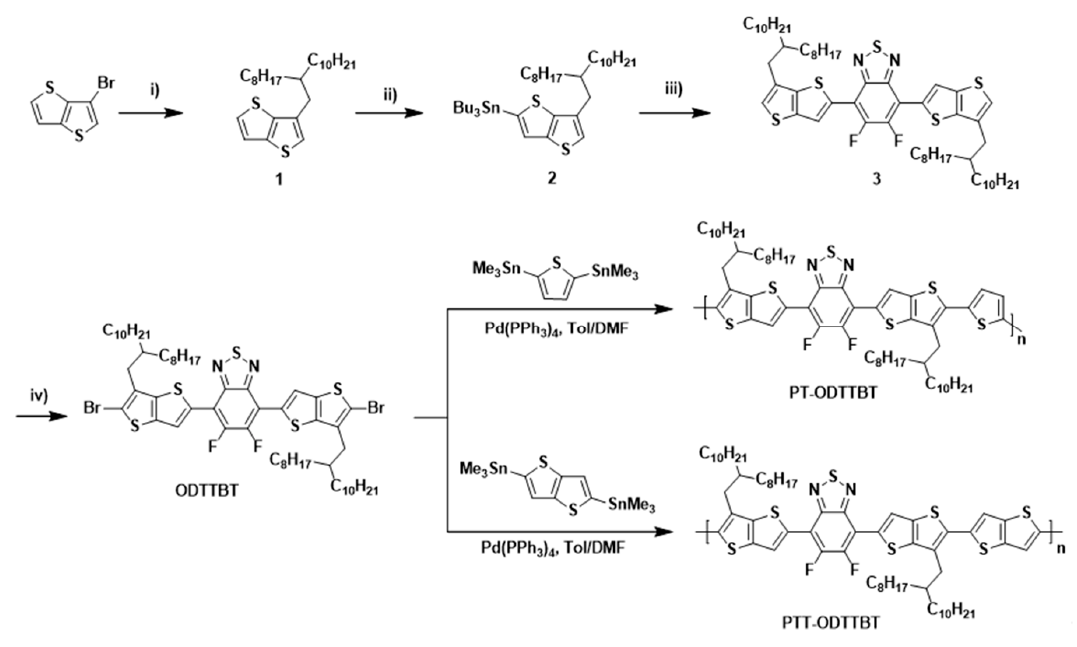
Scheme 1. Synthetic procedures for ODTTBT monomer and PT-ODTTBT and PTT-ODTTBT polymers. Reaction conditions: (i) 9-(Iodomethyl)nonandecane, P( o -tol) 3 , CoBr 2 , Mg, DMA, 70 °C; (ii) n -BuLi,